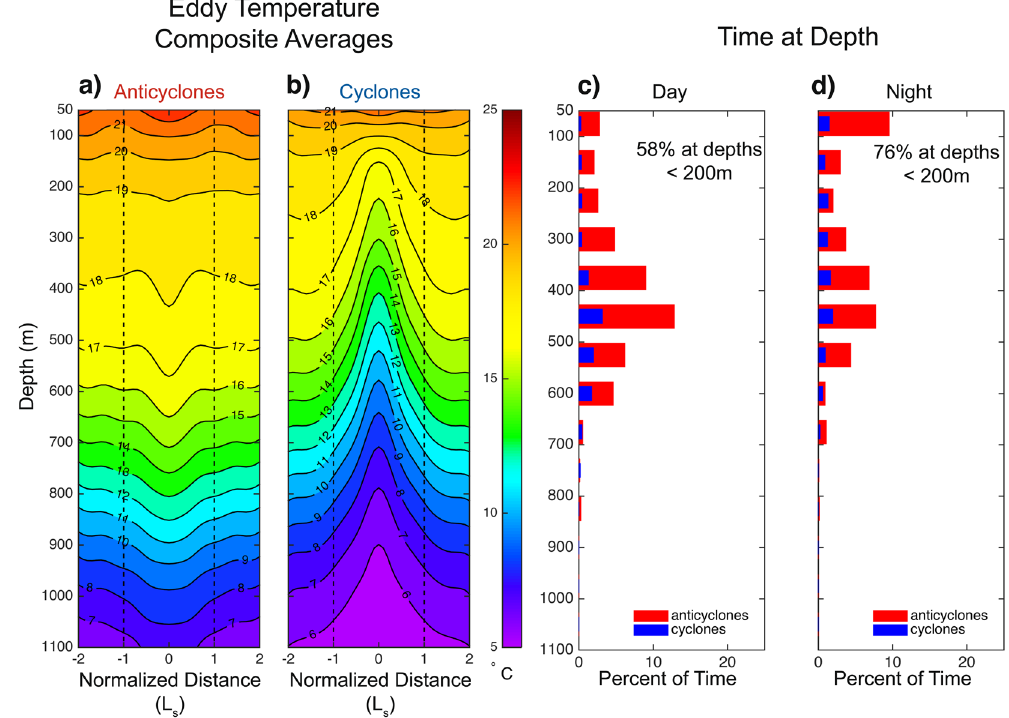
Figure 3. Composite averages of potential temperature from Argo floats in Gulf Stream ( a ) anticyclones and ( b ) cyclones. The time spent at depth computed from the 5-minute resolution dive data (see methods) in Gulf Stream anticyclones (red) and cyclones (blue) is shown as stepped lines during the ( c ) day and ( d )